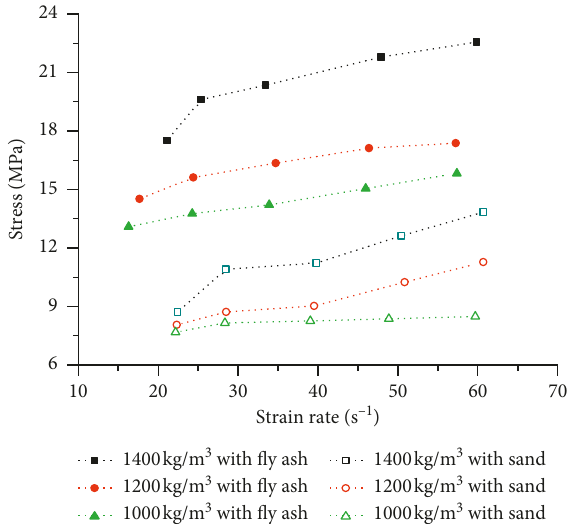
Figure 16: Relationship between the strain rate and ultimate compressive